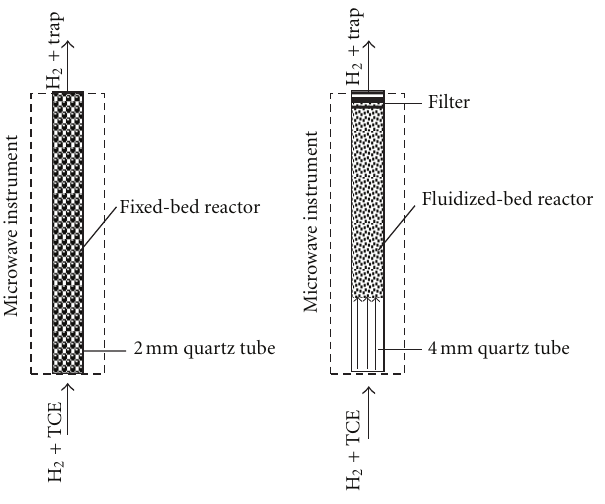
Figure 1: The schematic diagram comparing the fixed bed system with the fluidized bed system.